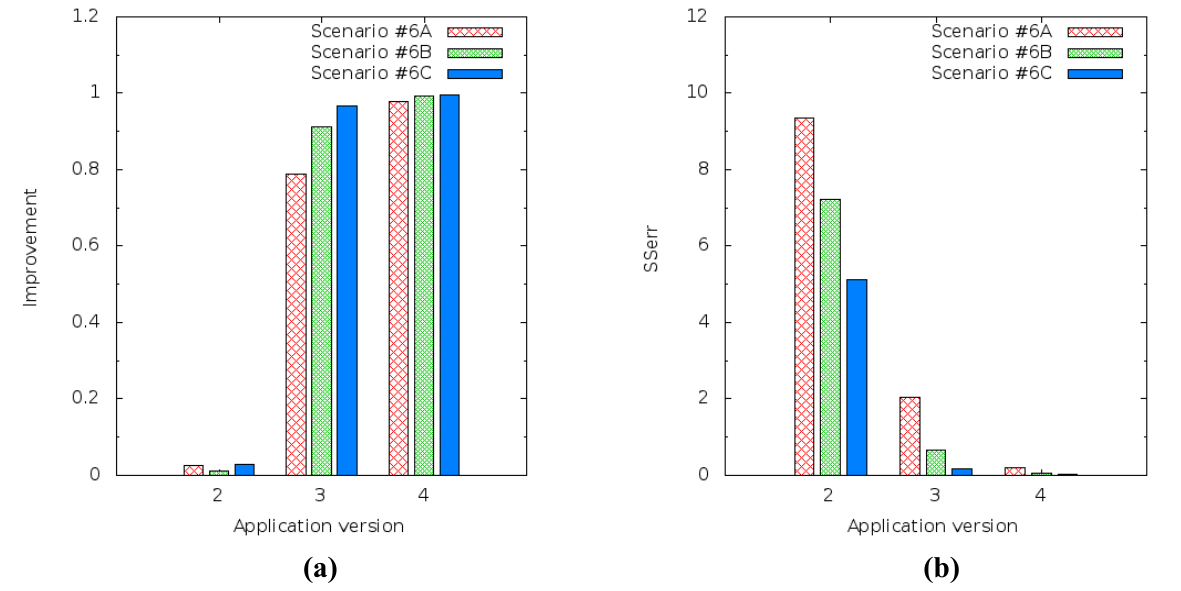
Figure 18. Improvement and SSerr of the prediction performed by application versions